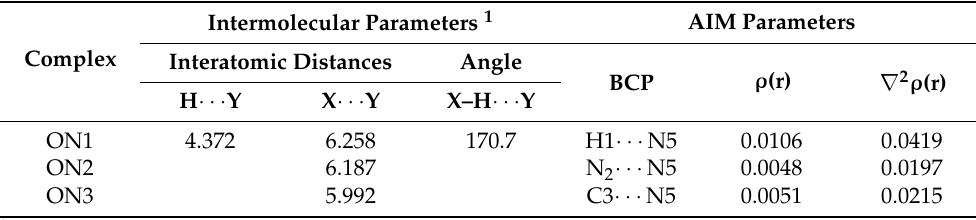
Table 1. Interatomic distances (Å), angles (degree) and electron density parameters of the inter- molecular bond critical points (au) of the HNCO complexes with N 2 (1:1) computed at the MP2/6-311++G(3df,3pd) level.